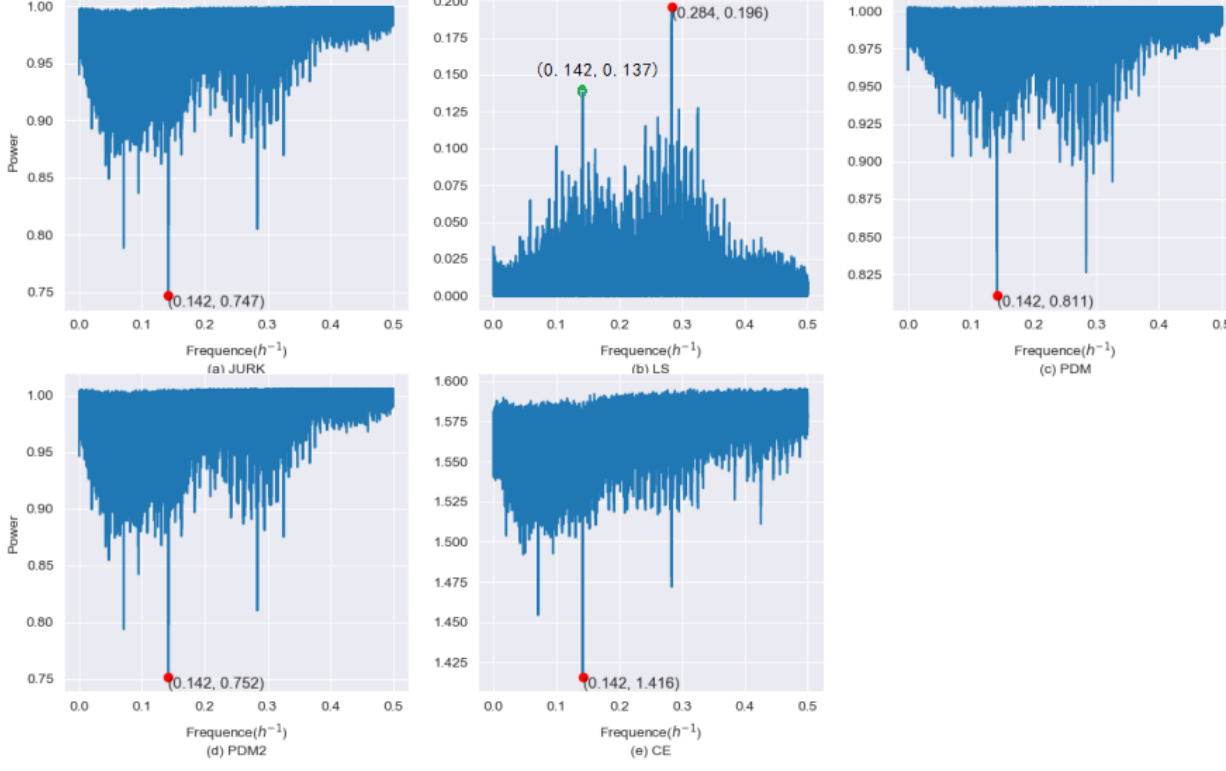
Figure 2. Taking No. 13 asteroid (Egeria) in the DAMIT dataset as an